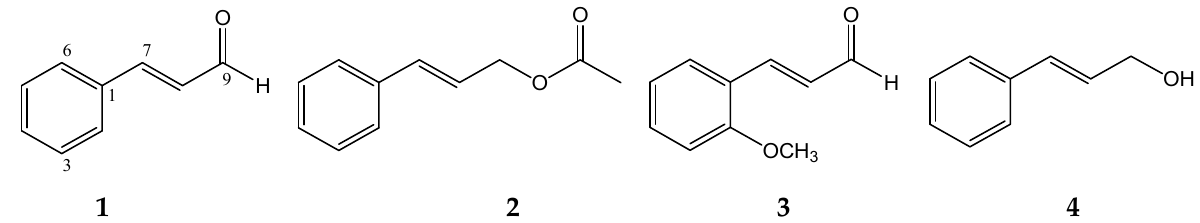
Figure 1. GC chromatograms of the EOs obtained by hydrodistillation from C. verum ( A ), C. cassia ( B ) and C. loureiroi ( C ). Table 2. Components of the EOs of three cinnamon species.